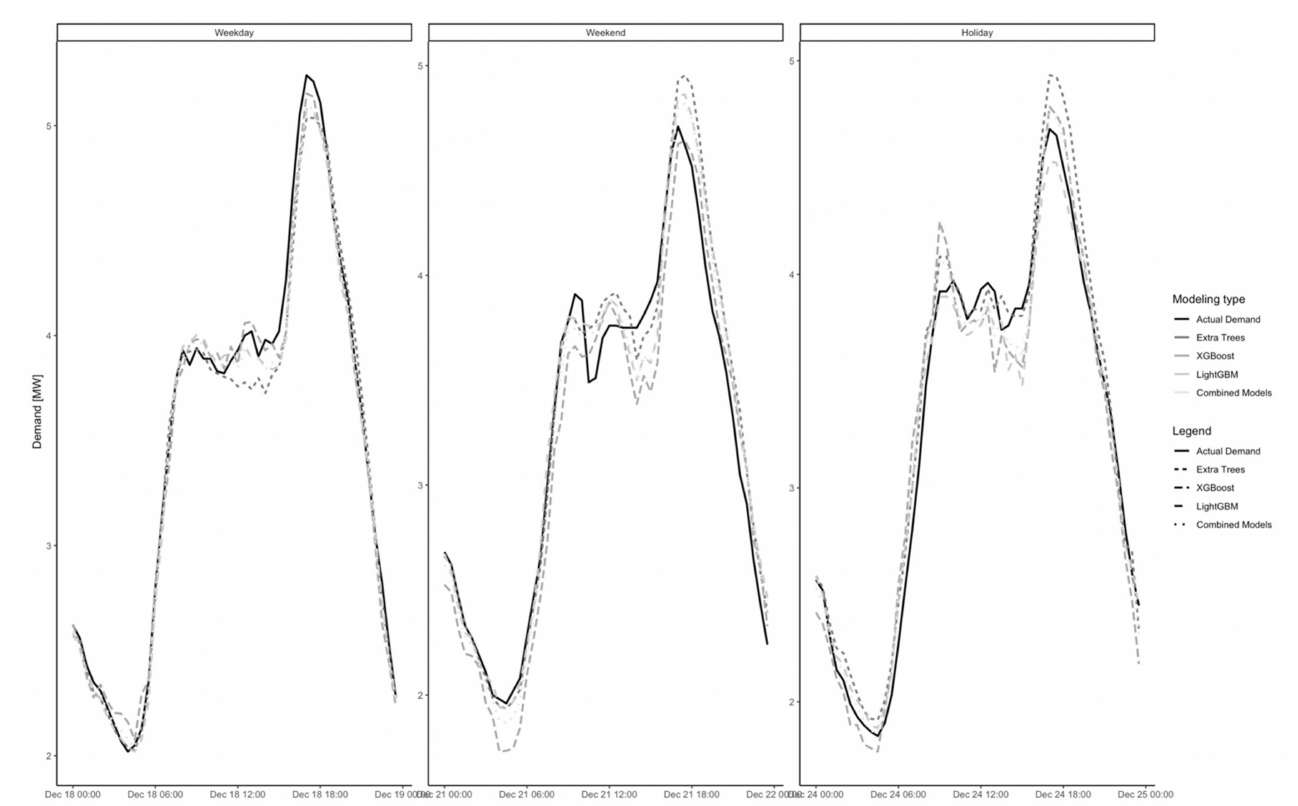
Figure 2. Demand forecasts for Extra Trees, XGBoost, LightGBM, the combined forecast and the actual demand on a weekday ( left ), weekend day ( middle ) and holiday ( right